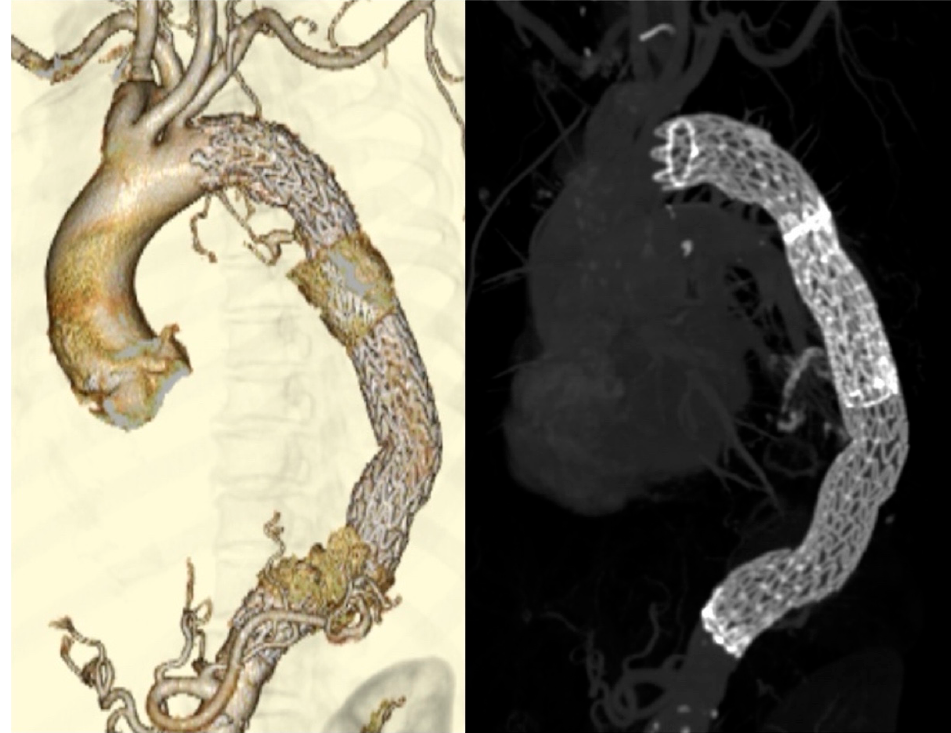
Figure 3. Postoperative contrast-enhanced computed tomographs showing no migration or fracture of the stent graft and no obvious endoleak. of the stent graft and no obvious